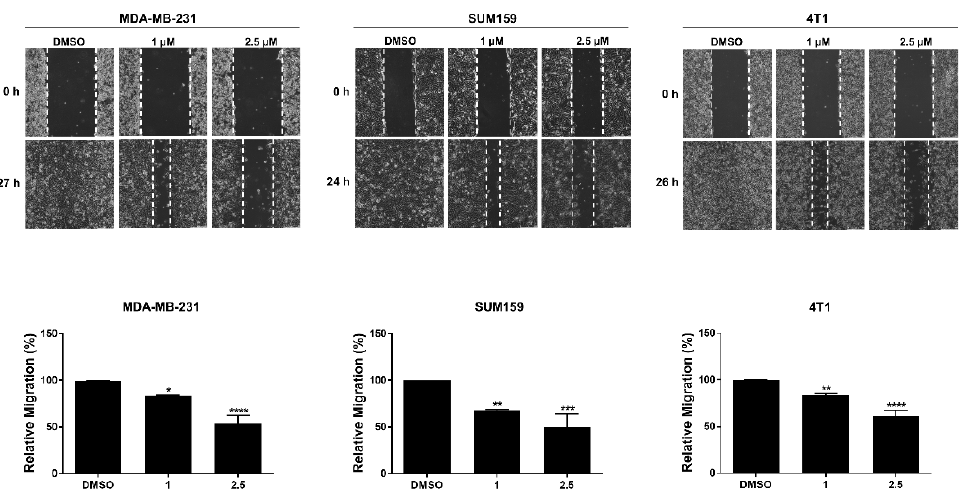
Figure 5. LLL12B inhibited migration in TNBC cells. ( A ) Wound healing assay was performed to detect the cell migration in MDA-MB-231, SUM159, and 4T1 cell lines with LLL12B treatment. Cell images show the initial and final scratches. ( B ) Quantification analysis of the wound area is shown. * p < 0.05, ** p < 0.01, *** p < 0.001 and **** p < 0.0001.